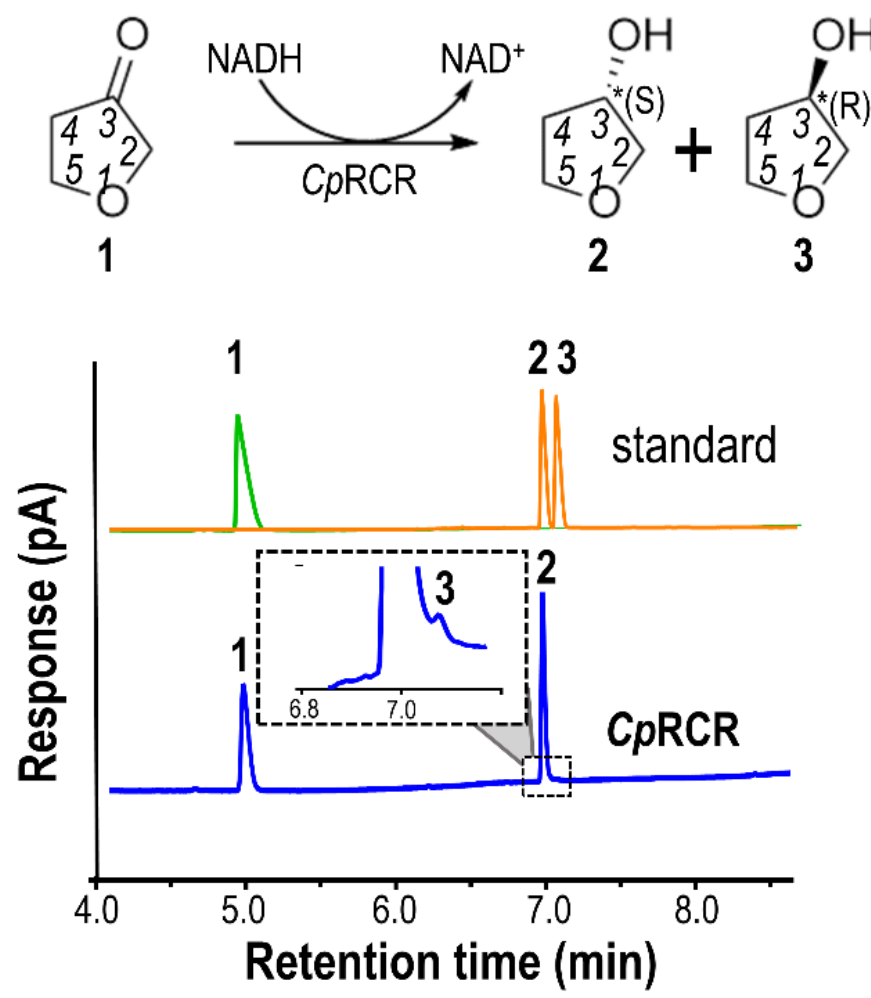
Figure 1. GC traces for chiral characterization, using the standards DHF-3-one ( 1 ), ( S )- DHF-3-ol ( 2 ), and racemic DHF-3-ol ( 2 & 3 ). The enzymatic reduction was performed for 8 h at 30 ◦ C with the reaction mixtures of Cp RCR (refer to methods section for details). For GC, Hydrodex- β -TBDAc column was used; after the first minute at 125 ◦ C, the temperature increased by 3 ◦ C/min to 135 ◦ C and was held for 1 min, and then increased by 50 ◦ C/min to 200 ◦ C and held for 2 min.